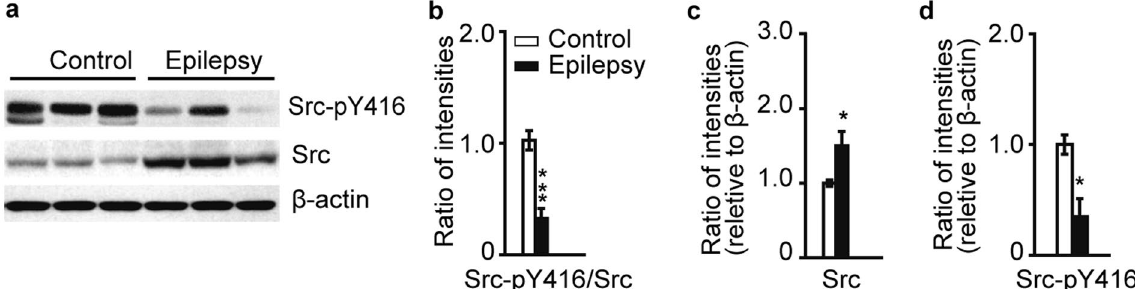
Figure 6. Decreased phosphorylation level of Src at Y416 in symptomatic epileptic tissues. ( a ) Immunoblotting of Src-pY416 and Src in human symptomatic epileptic tissues. ( b ) The phosphorylation of Src at Y416 is significantly decreased in human symptomatic epileptic tissues (n = 7). ( c ) Increased Src expression in human symptomatic epileptic tissues (n = 7). ( d ) The expression of Src-pY416 in human symptomatic epileptic tissues was significantly decreased (n = 7). * P < 0.05; *** P < 0.001. Unpaired two-tailed Student’s t-test. Data are represented as the mean ±